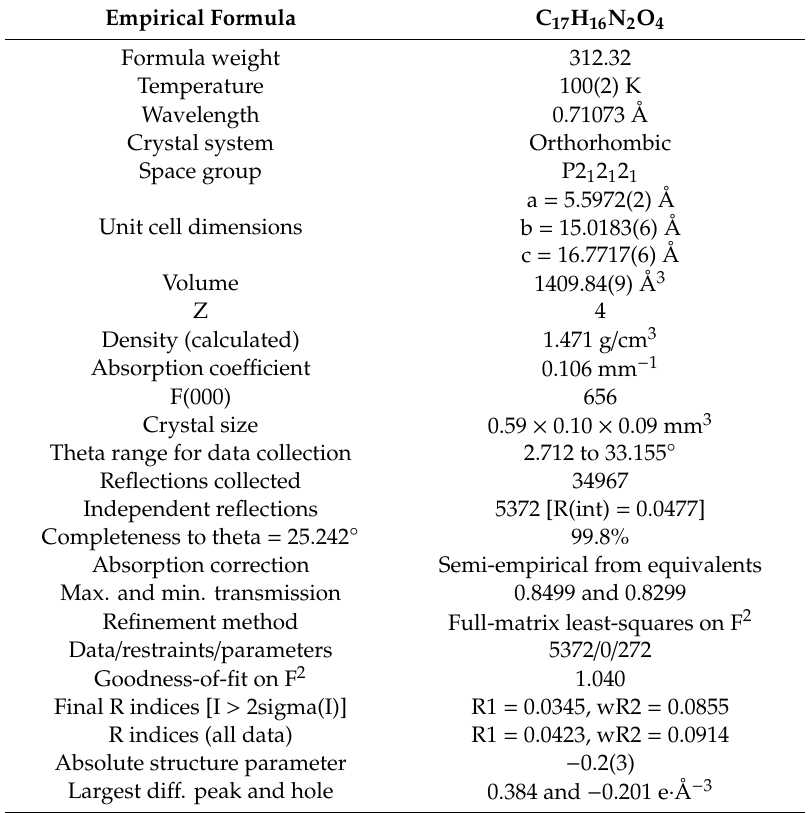
Table 1. Crystal data and structure refinement for compound 1